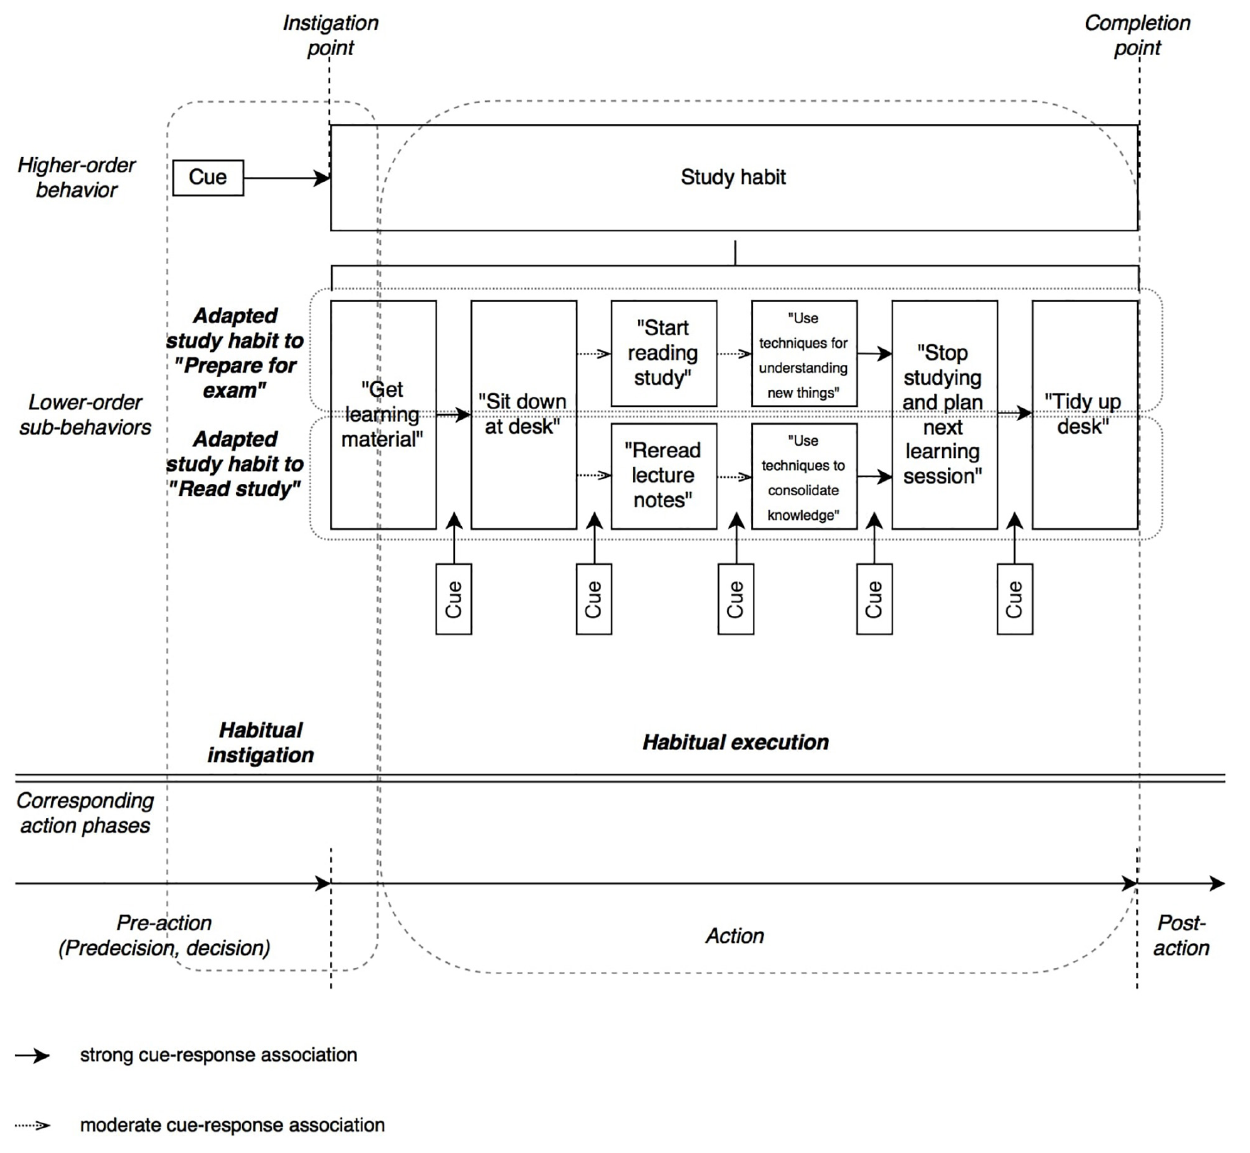
FIGURE 1 | A complex and flexible study habit that is adapted to different learning contents (adapted from Gardner et al.,